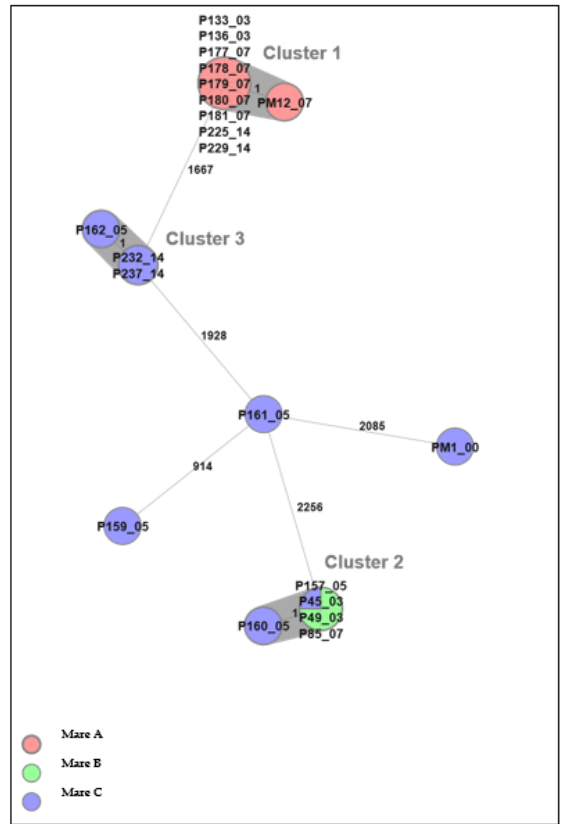
Figure 3. A minimum spanning tree (MST) was generated for the 21 E. coli isolates from the three mares in Uppsala, based on core genome multi-locus sequence typing (cgMLST) data. The text labels in circles denote the isolate ID followed by sampling day. Different colors denote individual mares. The grey background indicates identified clusters (genetically related isolates). Numbers next to the lines represent allelic differences, but the line length between isolates is not proportional to the numbers.